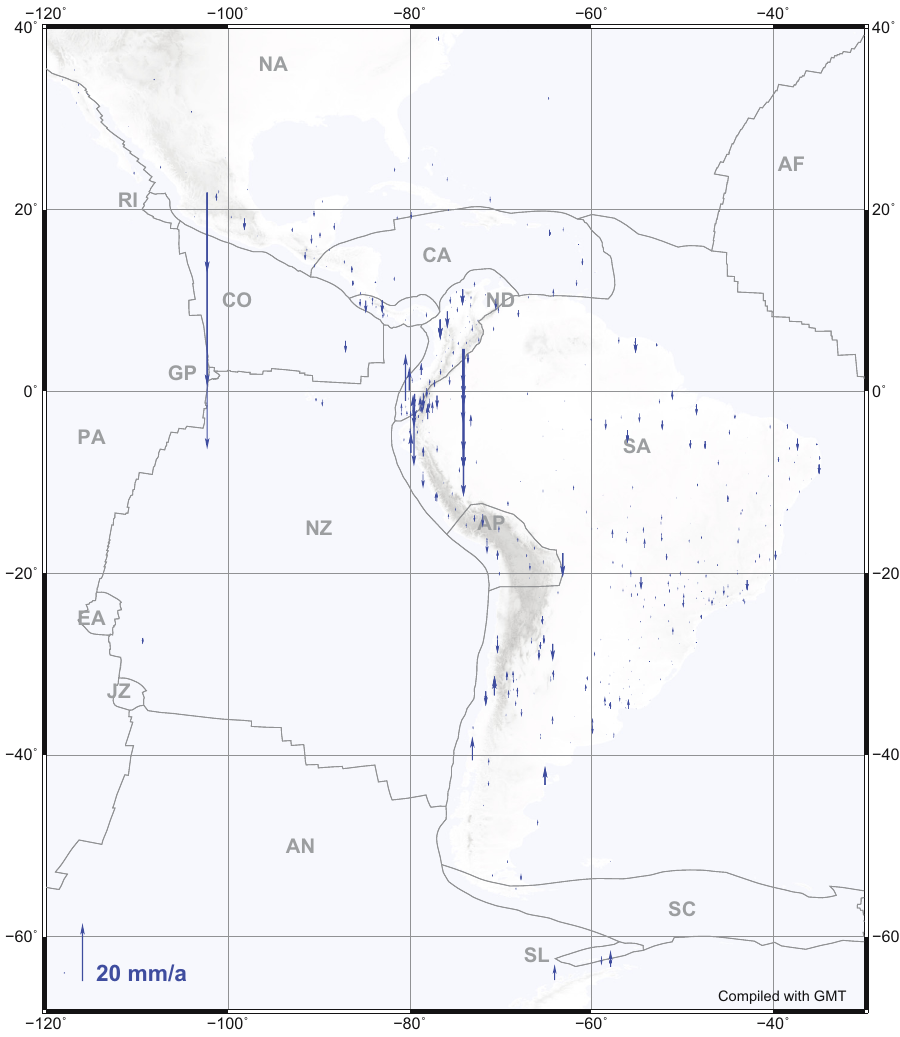
Figure 18: SIRGAS2022 vertical velocities.